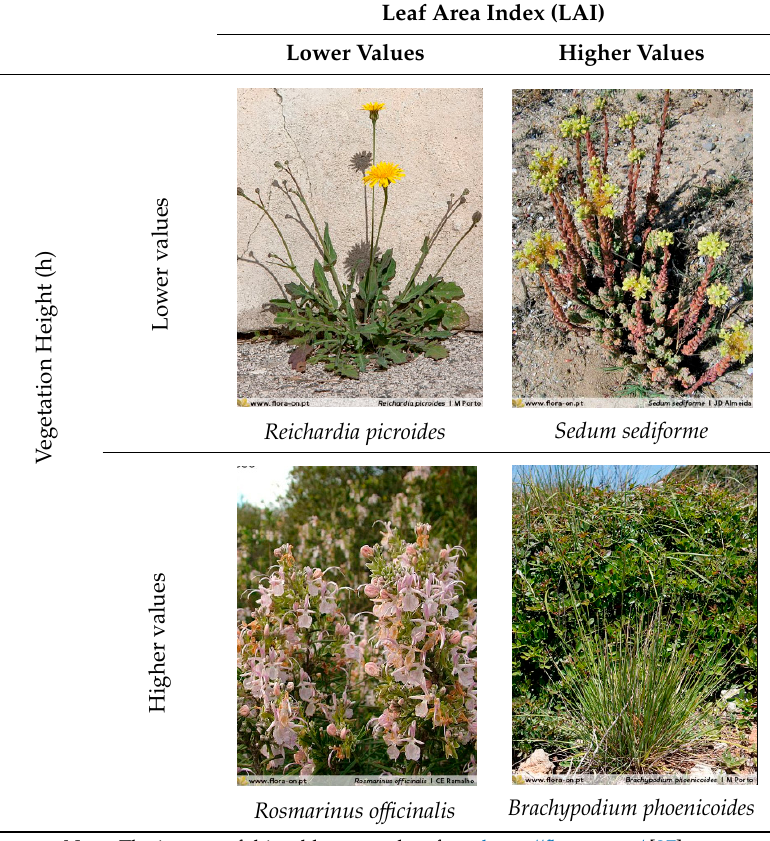
Table 1. Vegetation height (h) and leaf area index (LAI) of different species.